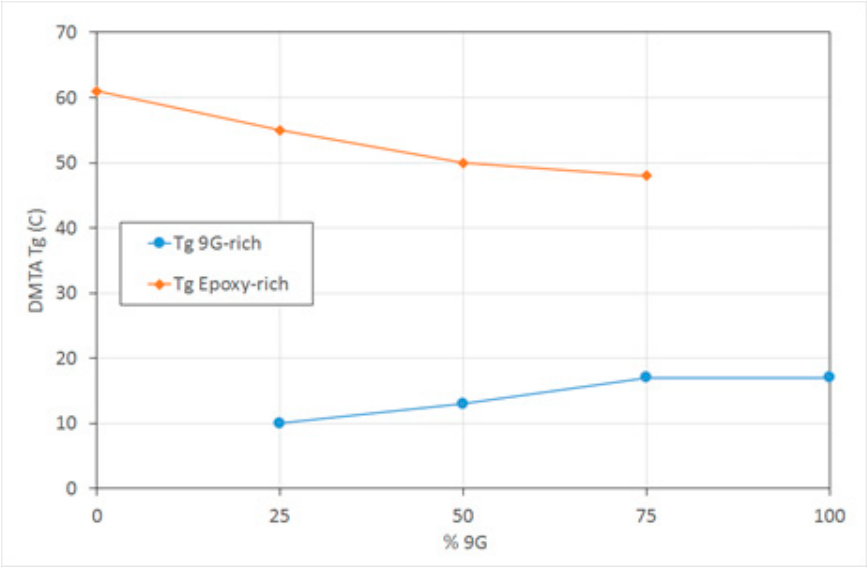
Figure 4. DMTA T g (tan δ peak temperature) of epoxy ‐ rich and 9G ‐ rich phases.